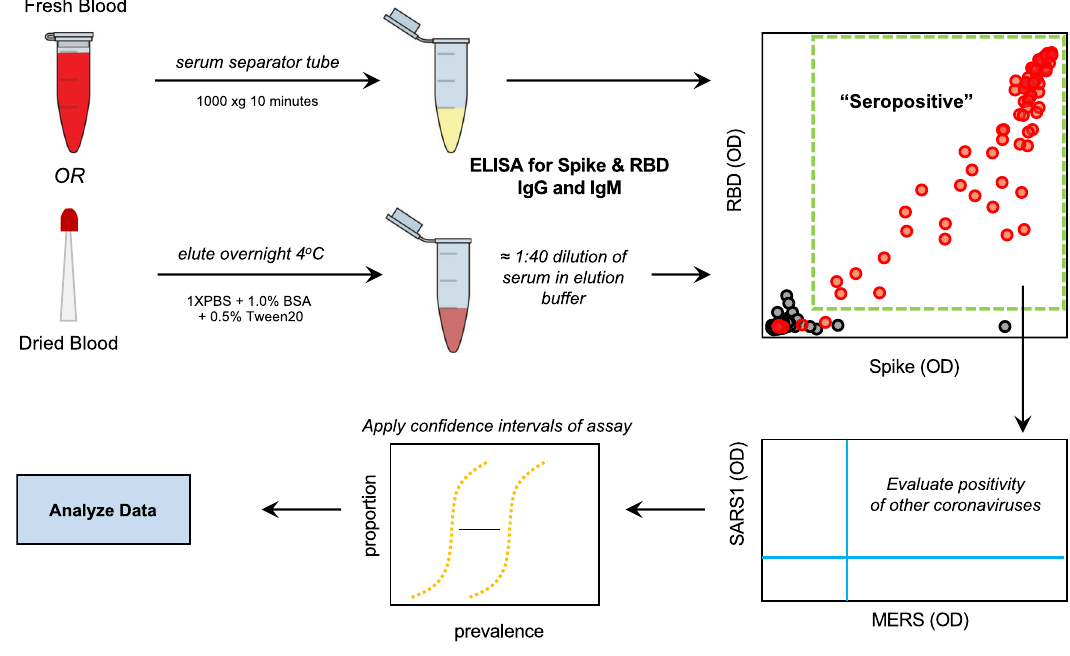
Fig. 1 Serology testing protocol for evaluation of SARS-CoV-2 seropositivity in a large-scale population. Utilizing both venipuncture-derived fresh blood and dried blood spots, we have standardized a dual-antigen ELISA platform for highly speci fi c (IgG = 100%, 95% con fi dence interval = 98.5 – 100) detection of SARS-CoV-2 antibodies for application in precise, large-scale serosurvey